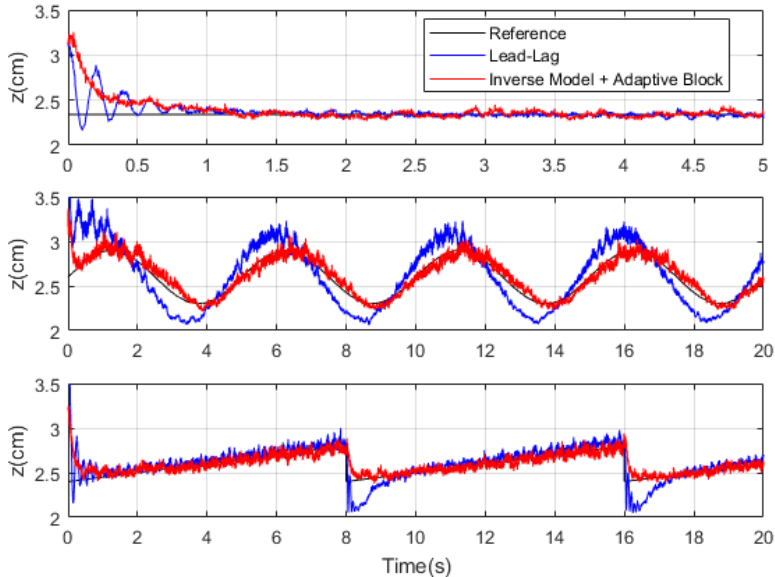
Figure 19. Comparison of system responses with lead–lag compensator and the inverse model with adaptive